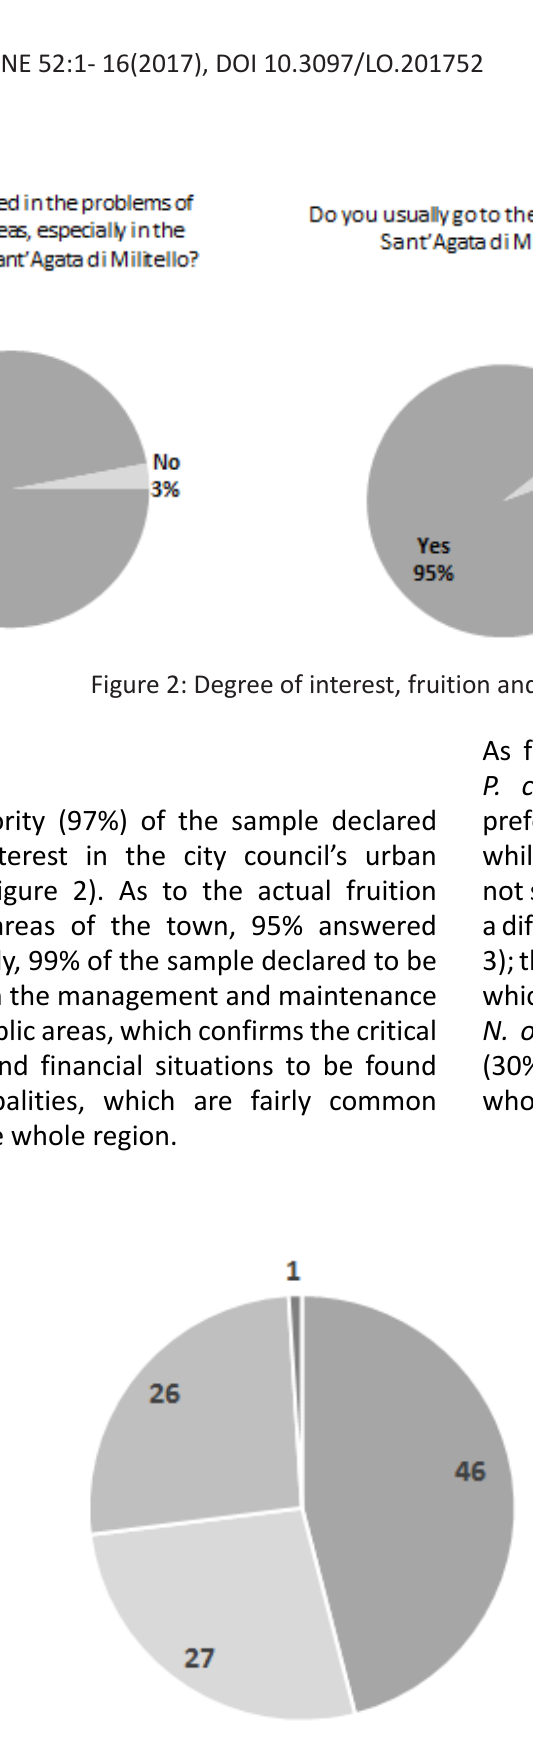
Figure 3: Species indicated by the sample for the substitution of the destroyed specimens of Phoenix